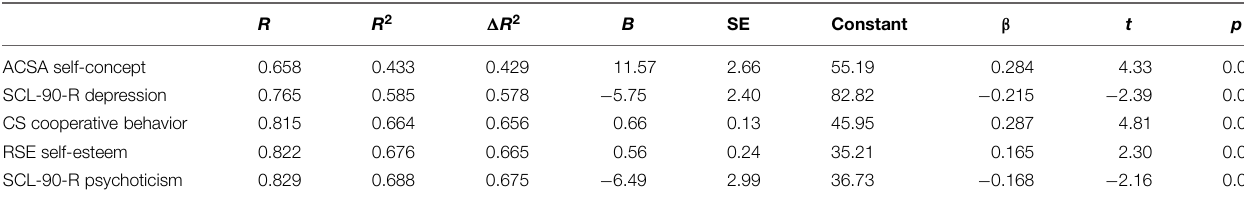
TABLE 4 | Multiple regression analysis for predictor variables of